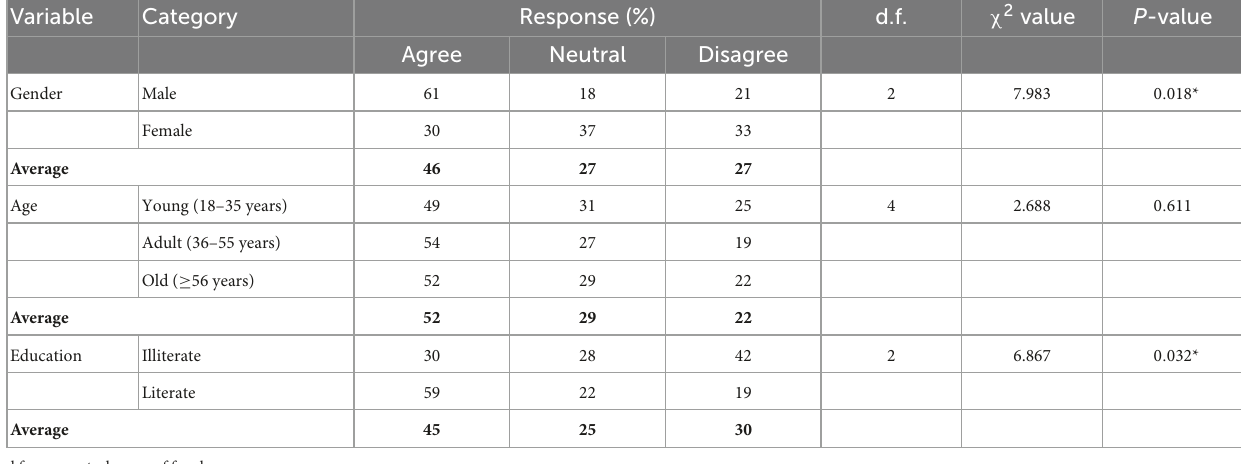
d.f.representsdegreesoffreedom. *Statisticallysignificantdifference. Averagevalueofeachresponse’sscale(option)arebold. TABLE 5 Respondents’ responses regarding their interest in pangolin conservation.